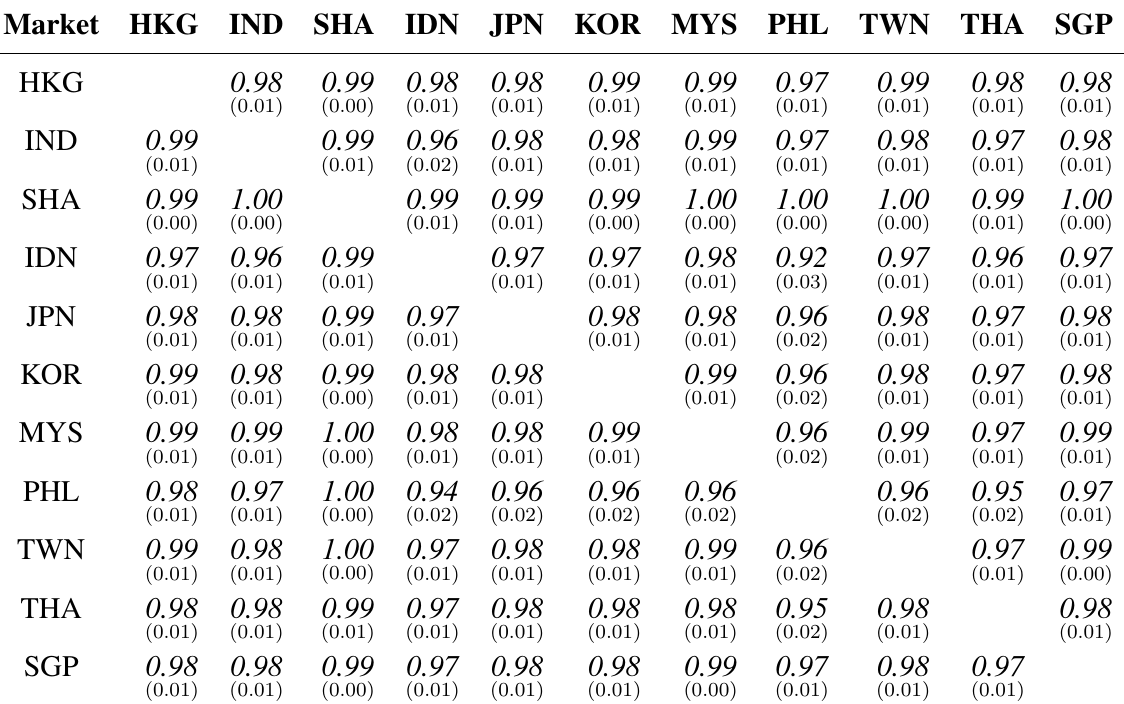
Table 12. Estimation results of  1 in the bivariate SV